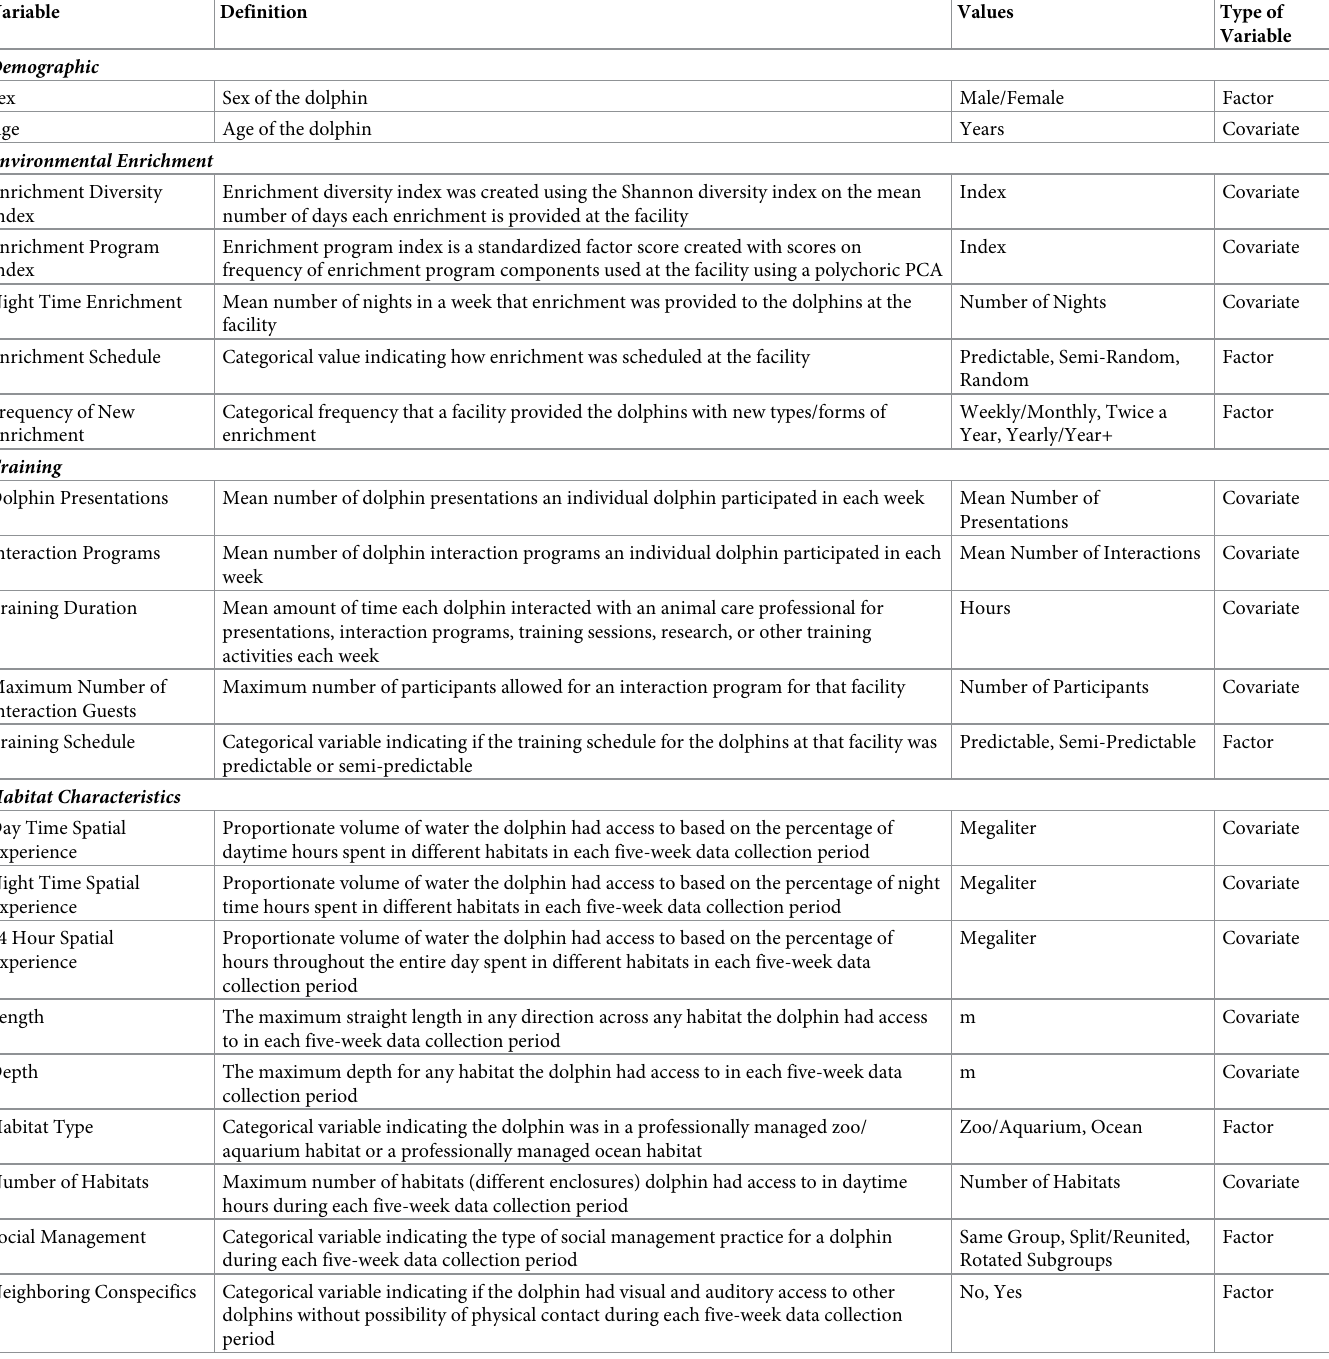
Table 1. Independent variables included in the